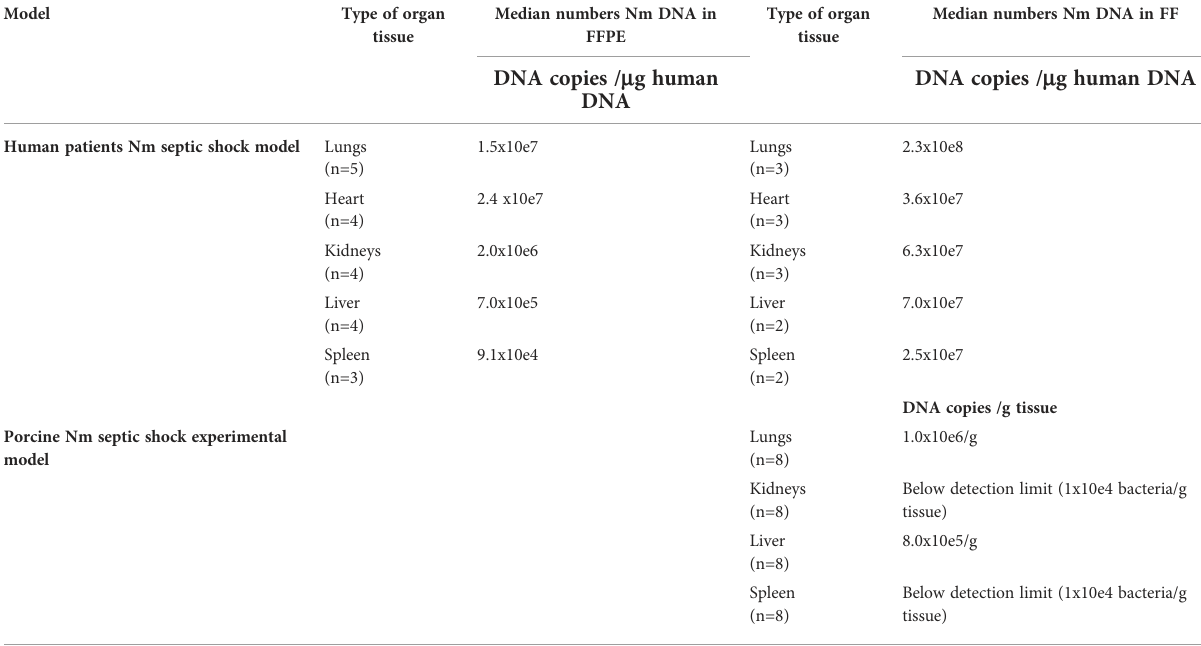
TABLE 2 Quanti fi cation of N.meningitidis (Nm) DNA in human and porcine tissue samples by q-PCR. In humans, Nm DNA presented as median numbers of Nm DNA copies/ m g human DNA and in porcinis as median numbers of DNA copies/g